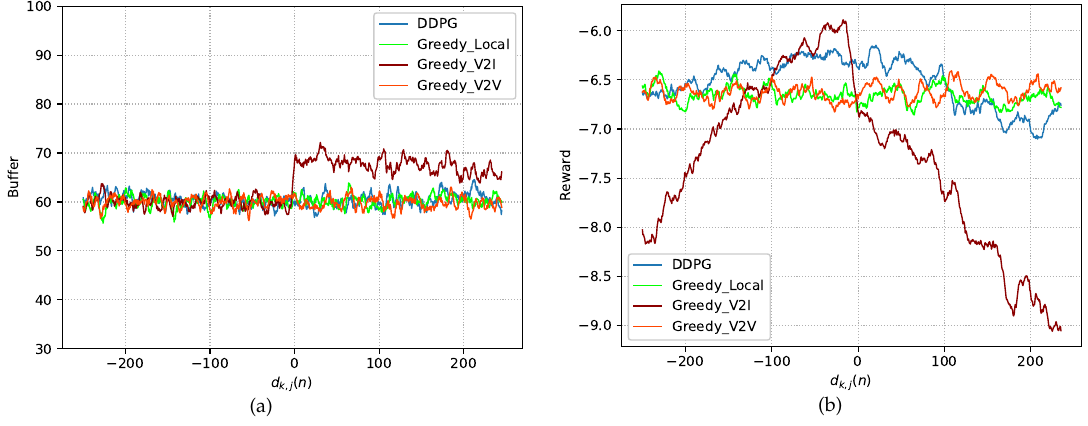
Figure 5. Performance. ( a ) Buffer capacity. ( b )